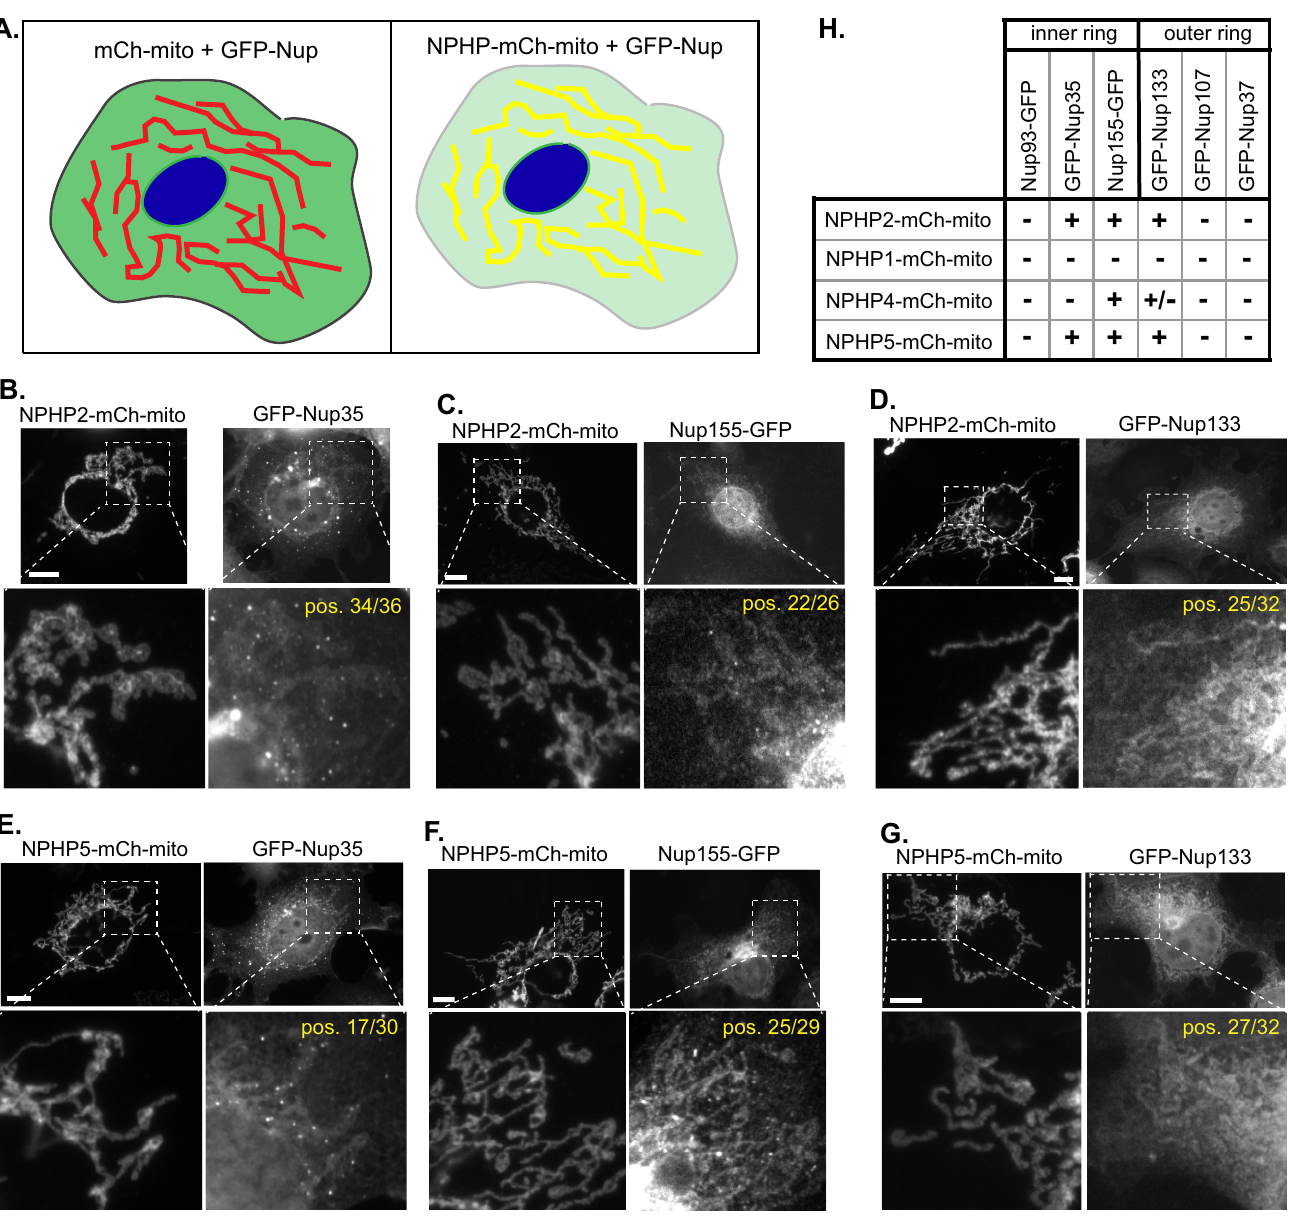
Fig 4. Identification of NPHP-NUP interactions by the knocksideways assay. (A) Schematic of the knocksideways assay. NPHP proteins were tagged with mCherry (mCh) and targeted to the mitochondrial surface by fusion to a mitochondrial targeting sequence (mito). The NPHP-mCh-mito bait was co-expressed with an EGFP- tagged nucleoporin (GFP-Nup). An interaction between the NPHP and nucleoporin proteins recruits the GFP-Nup to the mCh-labeled mitochondrial surface. (B-D) NPHP2-mCh-mito recruits the inner ring nucleoporins (B) GFP-Nup35 and (C) Nup155-EGFP3 and the outer ring nucleoporin (D) GFP-Nup133 to the mitochondrial surface. (E-G) NPHP5-mCh-mito recruits the inner ring nucleoporins (E) GFP-Nup35 and (F) Nup155-EGFP3 and the outer ring nucleoporin (G) GFP-Nup133 to the mitochondrial surface. Scale bars, 10 μ m. Yellow text indicates the number of cells positive (pos.) for a knocksideways interaction. (H) Summary of the results. +, recruitment of GFP-Nup observed in > 50% of cells; +/-, recruitment of GFP-Nup observed in 10–50% of cells; -, recruitment of GFP-Nup observed in < 10% of cells.